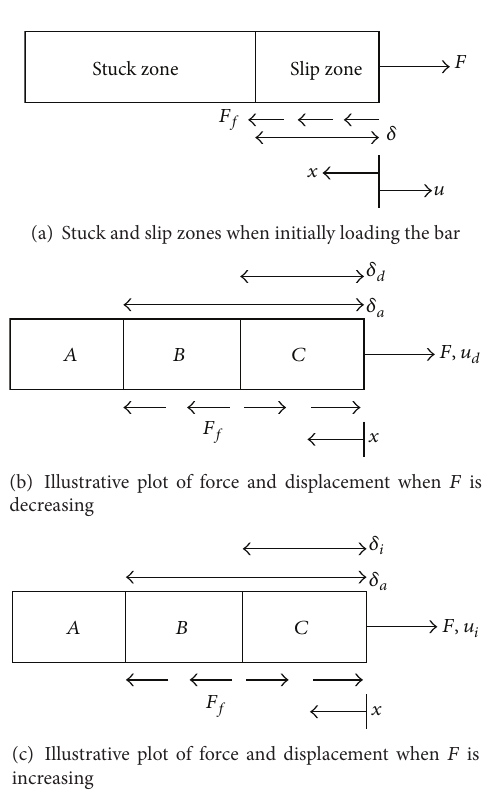
Figure 2: Microslip model for